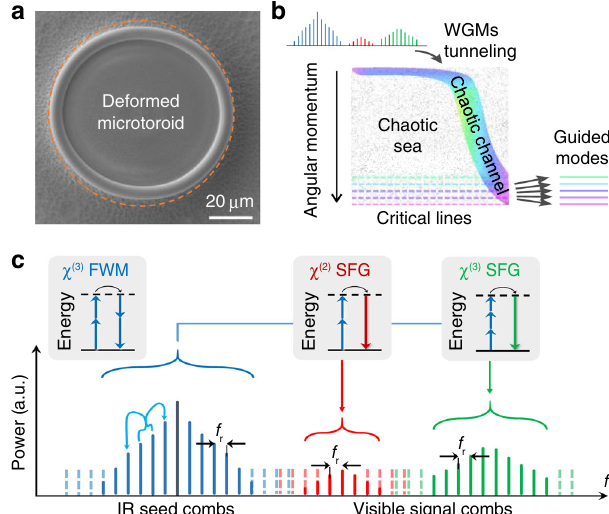
Fig. 1 Schematic for broadband microcombs in the deformed microcavity. a Scanning electron microscope image of a deformed microresonator. As a comparison, a circular contour is shown in dashed orange line. b Conceptual illustration of chaos-assisted momentum transformation and dynamical tunneling from whispering-gallery-modes (WGMs) to chaotic states. c Schematic of the nonlinear frequency conversion from infrared (IR) to visible wavelengths in the deformed cavity with four-wave mixing (FWM) and sum-frequency generation (SFG, including harmonic generations as a special